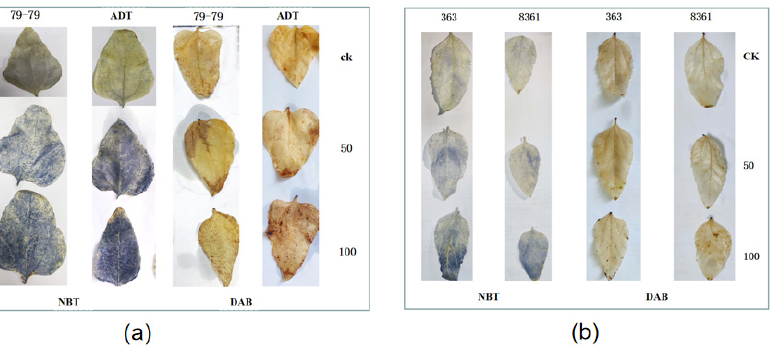
Figure 8. Histochemical detection of H 2 O 2 and O 2 − using DAB and NBT staining in the leaves of sunflower varieties exposed to Cd after ten days. The intense brown color indicates the presence and accumulation of H 2 O 2 and O 2 − . ( a ) 79 − 79 and ADT, ( b ) 363 and